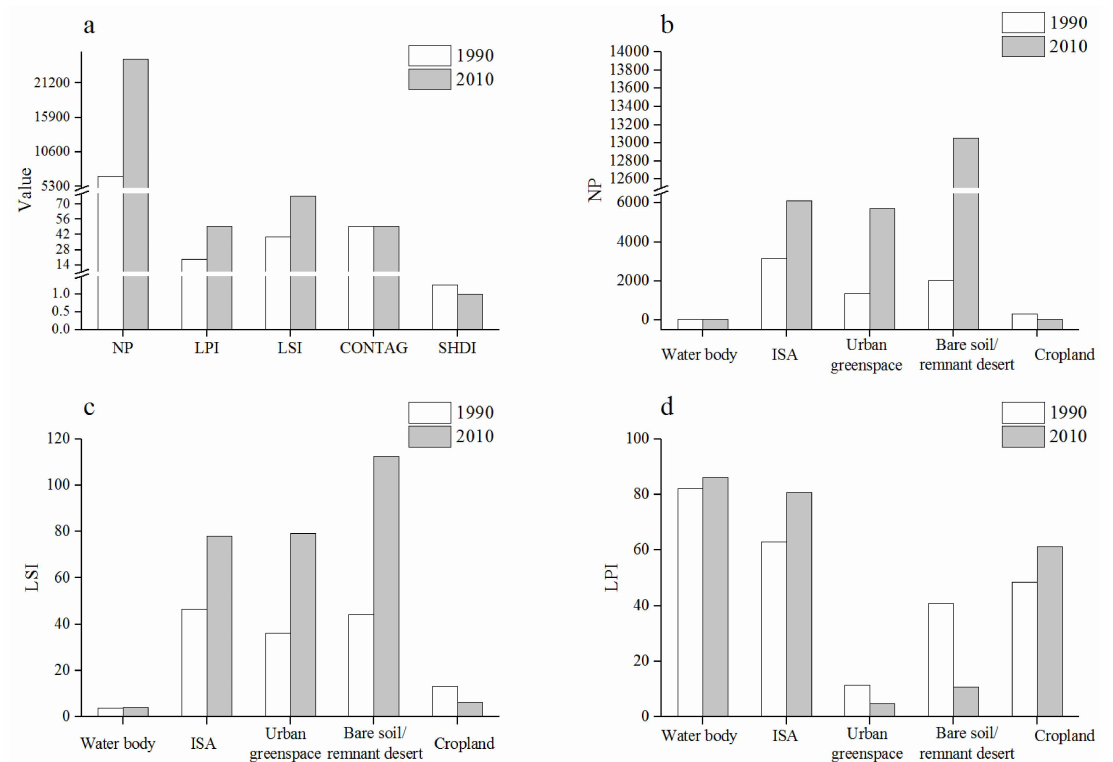
Figure 5. Change of number of patch (NP), largest patch index (LPI), landscape shape index (LSI), contagion index (CONTAG) of and Shannon diversity index (SHDI) values of all land—cover types ( a ); and NP ( b ); LSI ( c ); LPI ( d ) of each land cover types in Urumqi from 1990 to